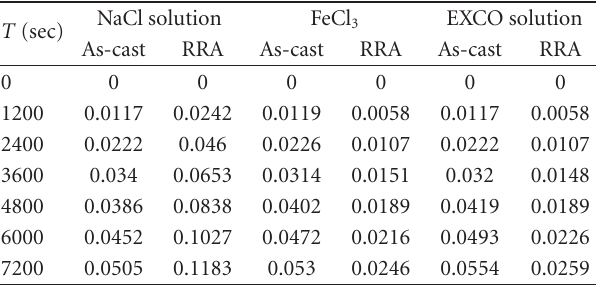
Table 14: Electrochemical corrosion rate for the 2.02% Mg specimen.